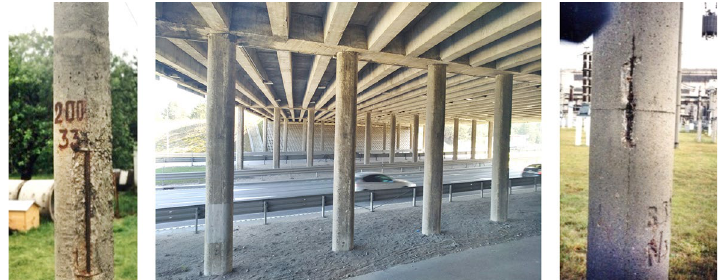
Fig. 1. Circular cross-section reinforced concrete structures damaged by corrosion